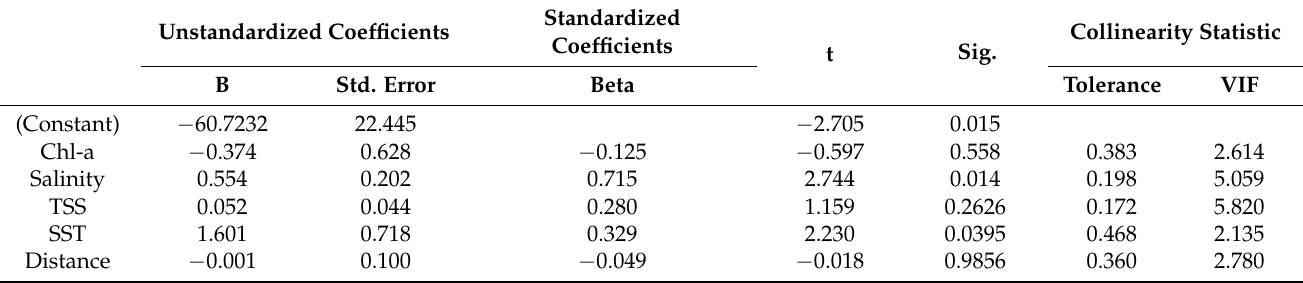
Table 2. Multiple linear regression test